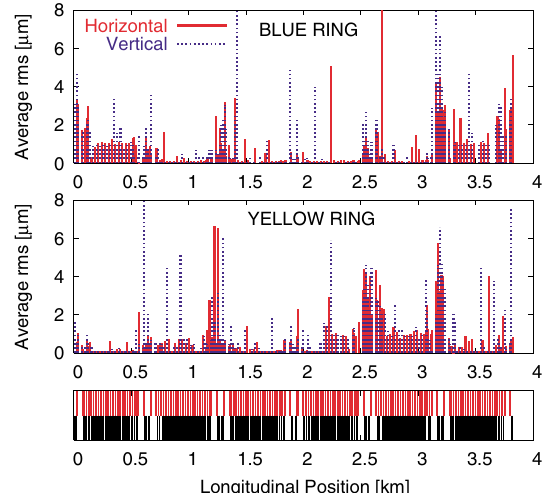
FIG. 6. (Color) Histograms of the rms observable for the two rings and the two planes. The total number of signals used in the histograms are shown.